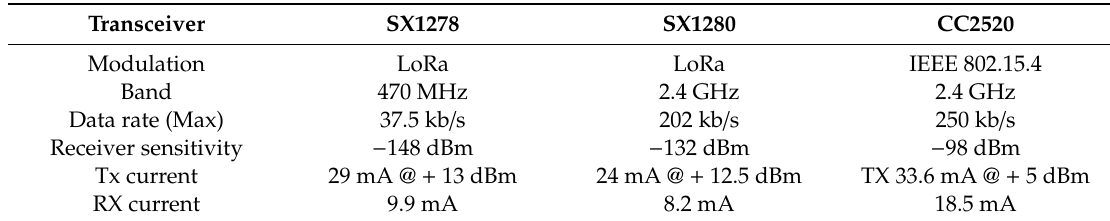
Table 2. Typical transceiver parameters